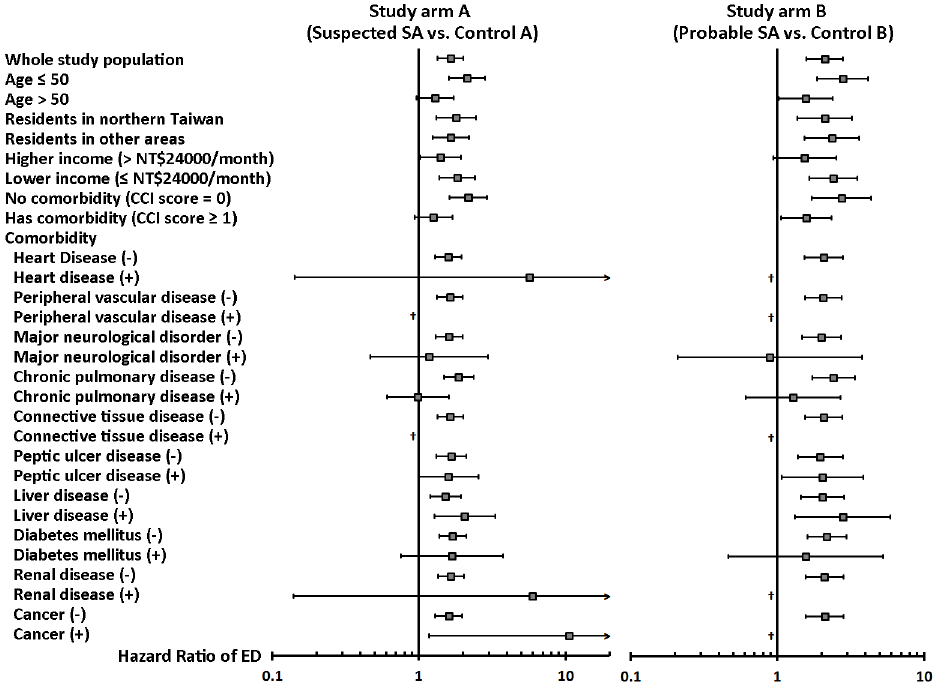
Fig 3. Stratified analyses of the multivariable Cox proportional hazards regression analyses. The results are presented with adjusted HRs (95% CI) of sleep apnea, which are adjusted for age, residency, income and the presence of various comorbidities (except for the variable used for stratification). * Abbreviations: SA = sleep apnea; CCI = Charlson Comorbidity Index; HR = hazard ratio; CI = confidence interval. † : Due to small sample size, hazard ratio cannot be